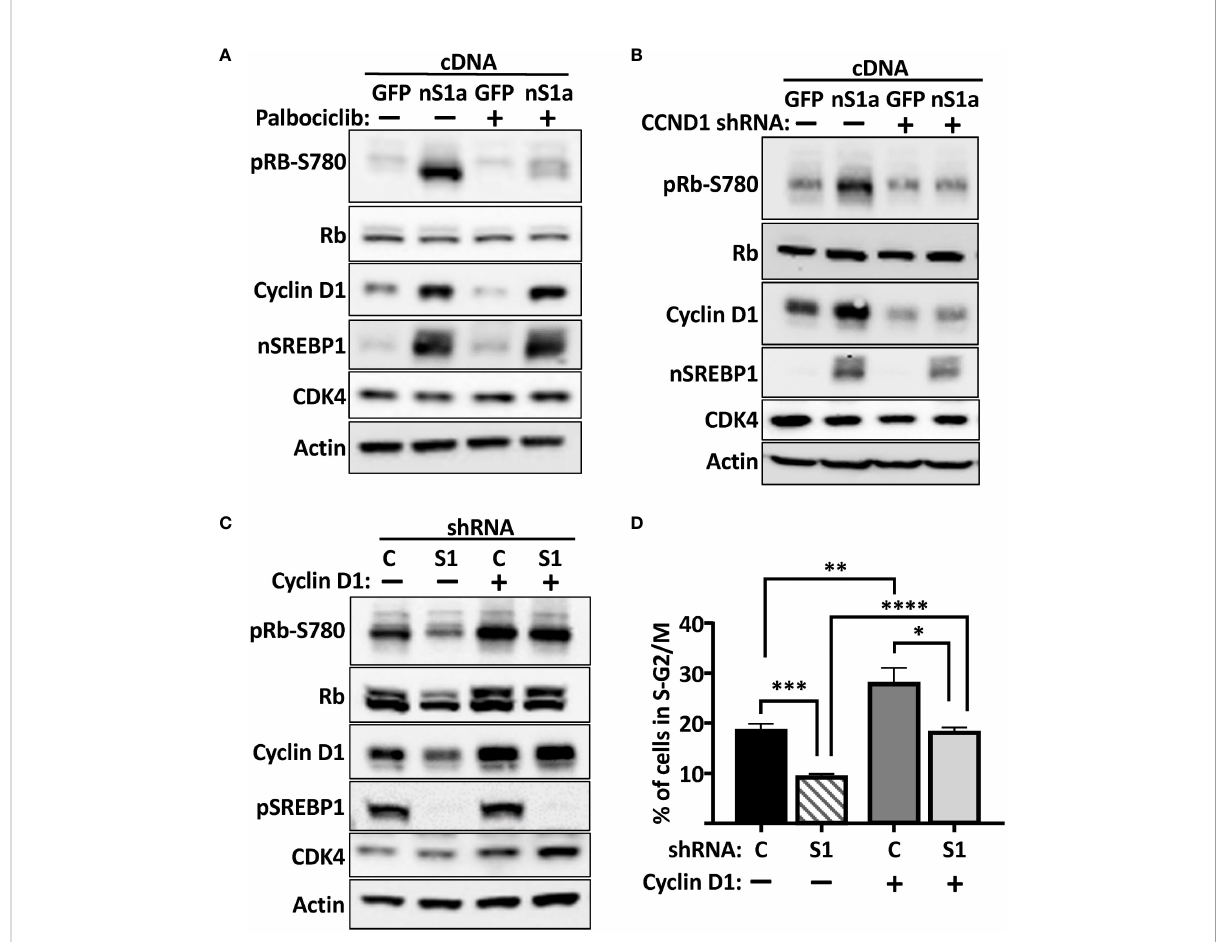
FIGURE 7 The SREBP1-dependent induction of cyclin D1 promotes the phosphorylation of Rb. (A) HepG2 cells were transduced with lentiviruses expressing GFP or nuclear SREBP1a ( nS1a ), and 48 h following transduction, the cells were treated with or without the cdk4/6 inhibitor palbociclib (10 m M) for 6 h. The levels of cyclin D1, Rb, and the nuclear form of SREBP1 ( nSREBP1 ), and the phosphorylation of Rb on serine 780 ( pRb-S780 ) were analyzed by Western blotting. b -Actin was used as loading control. (B) HepG2 cells were transduced with lentiviruses expressing GFP or nuclear SREBP1a ( nS1a ) together with non-targeted (C) or cyclin D1 ( CCND1 ) shRNA. Forty-eight hours after transduction, the levels of cyclin D1, Rb, CDK4, and nuclear SREBP1 ( nSREBP1 ), and the phosphorylation of Rb on serine 780 ( pRb-S780 ) were analyzed by Western blotting. b -Actin was used as loading control. (C) HepG2 cells were transduced with lentiviruses expressing GFP or cyclin D1 together with non-targeted (C) or SREBP1 ( S1 ) shRNA. Forty-eight hours after transduction, the levels of cyclin D1, Rb, CDK4 and the precursor form of SREBP1 ( pSREBP1 ), and the phosphorylation of Rb on serine 780 ( pRb-S780 ) were analyzed by Western blotting. b -Actin was used as loading control. (D) The same cells as in (C) were also fi xed and stained with propidium iodine, and the DNA content was analyzed by FACS. Signi fi cance was determined by one-way ANOVA with Tukey ’ s multiple comparisons adjustment (D) . p-values lower than 0.05 were considered statistically signi fi cant. *p < 0.05, **p < 0.01, ***p < 0.001, and ****p <